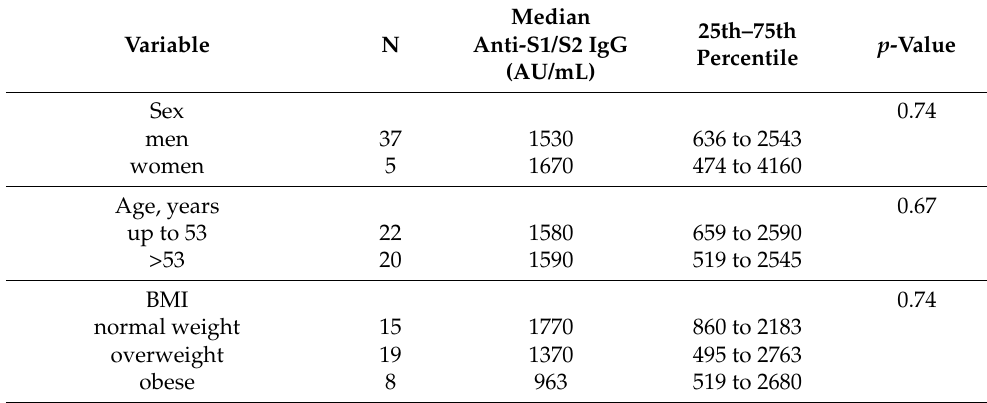
Table 1. Median anti-SARS-CoV-2 S1/S2 IgG measured 4 weeks after BNT162b2 booster dose in 42 HIV-infected individuals according to demographical and clinical variables.